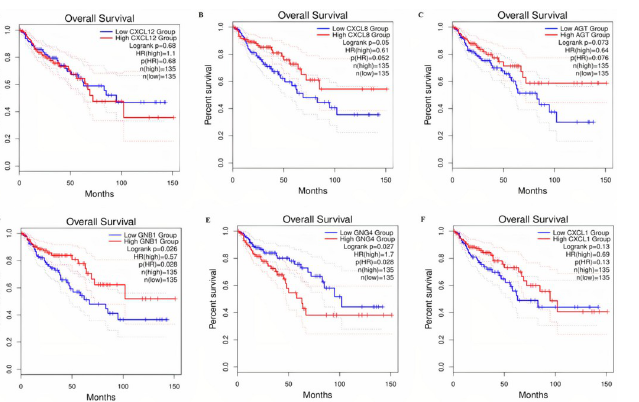
Fig 13. The COAD related prognostic information of the real hub genes obtained via GEPIA database. The calculated prognostic value of: (A) CXCL12, (B) CXCL8, (C) AGT, (D) GNB1, (E) GNG4, (F) CXCL1 gene. Blue color indicates this low expression while red color indicates the high expression of a gene.